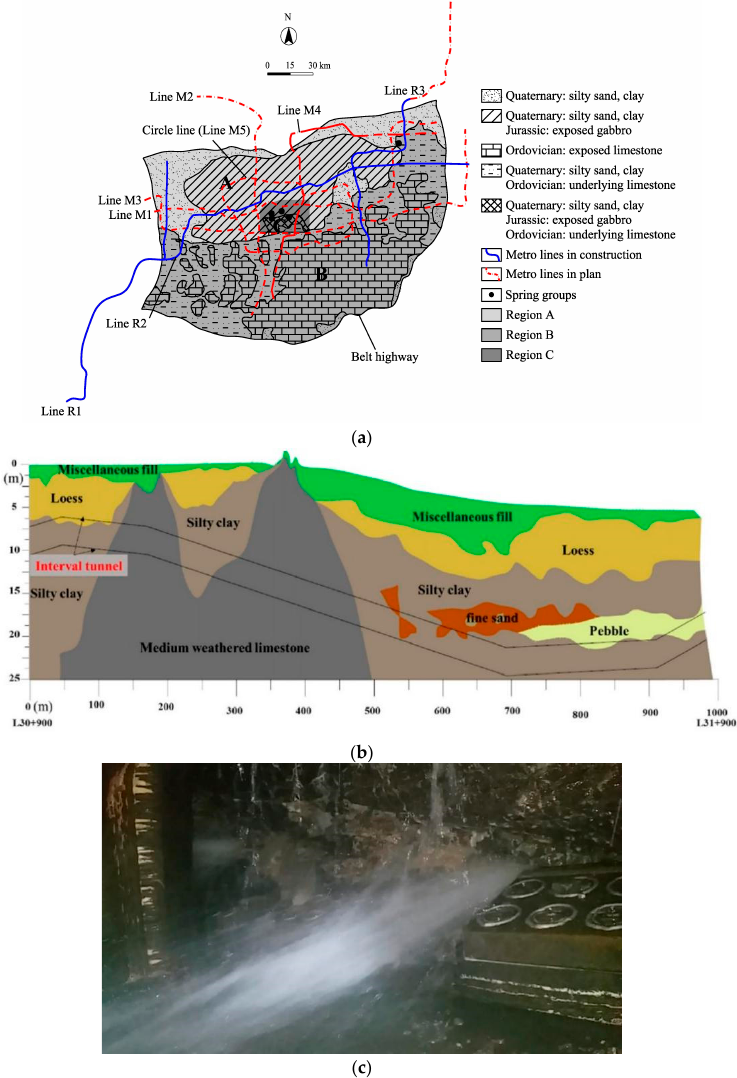
Figure 11. Overview of the study area: ( a ) Jinan metro planning map; ( b ) geological cross-section of the tunnel between Wangfuzhuang and Dayangzhuang [27,28]; ( c ) water inrush at the tunnel face.